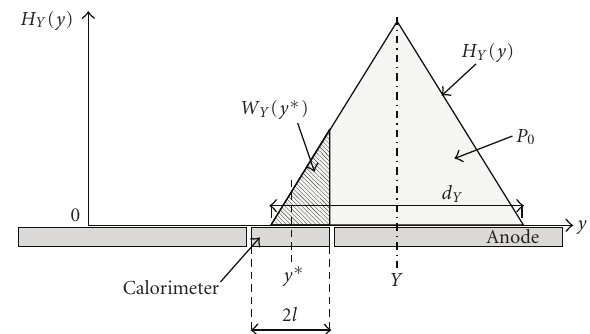
Figure 5: Schematic illustration of the heat flow from the arc to a calorimeter.